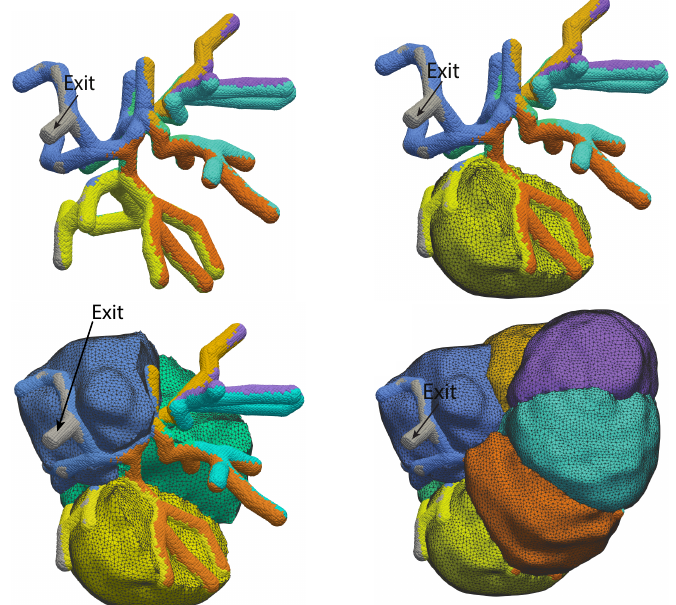
Figure 2. Three-dimensional reconstruction of a group of seven salivary gland acinar cells, based on data from optical slices. The panels show four different views of the same group of cells, with progressively more cells included, so that the internal structure can be more clearly seen. The top left panel shows the reconstruction of the apical lumen, with the exit to the duct shown. It is colour-coded by which cell secretes into that branch of the lumen. The top right panel shows the same lumen, but now with one acinar cell included, to demonstrate how the fingers of the lumen wrap around the cell. The bottom two panels show three and seven cells, with the same colour